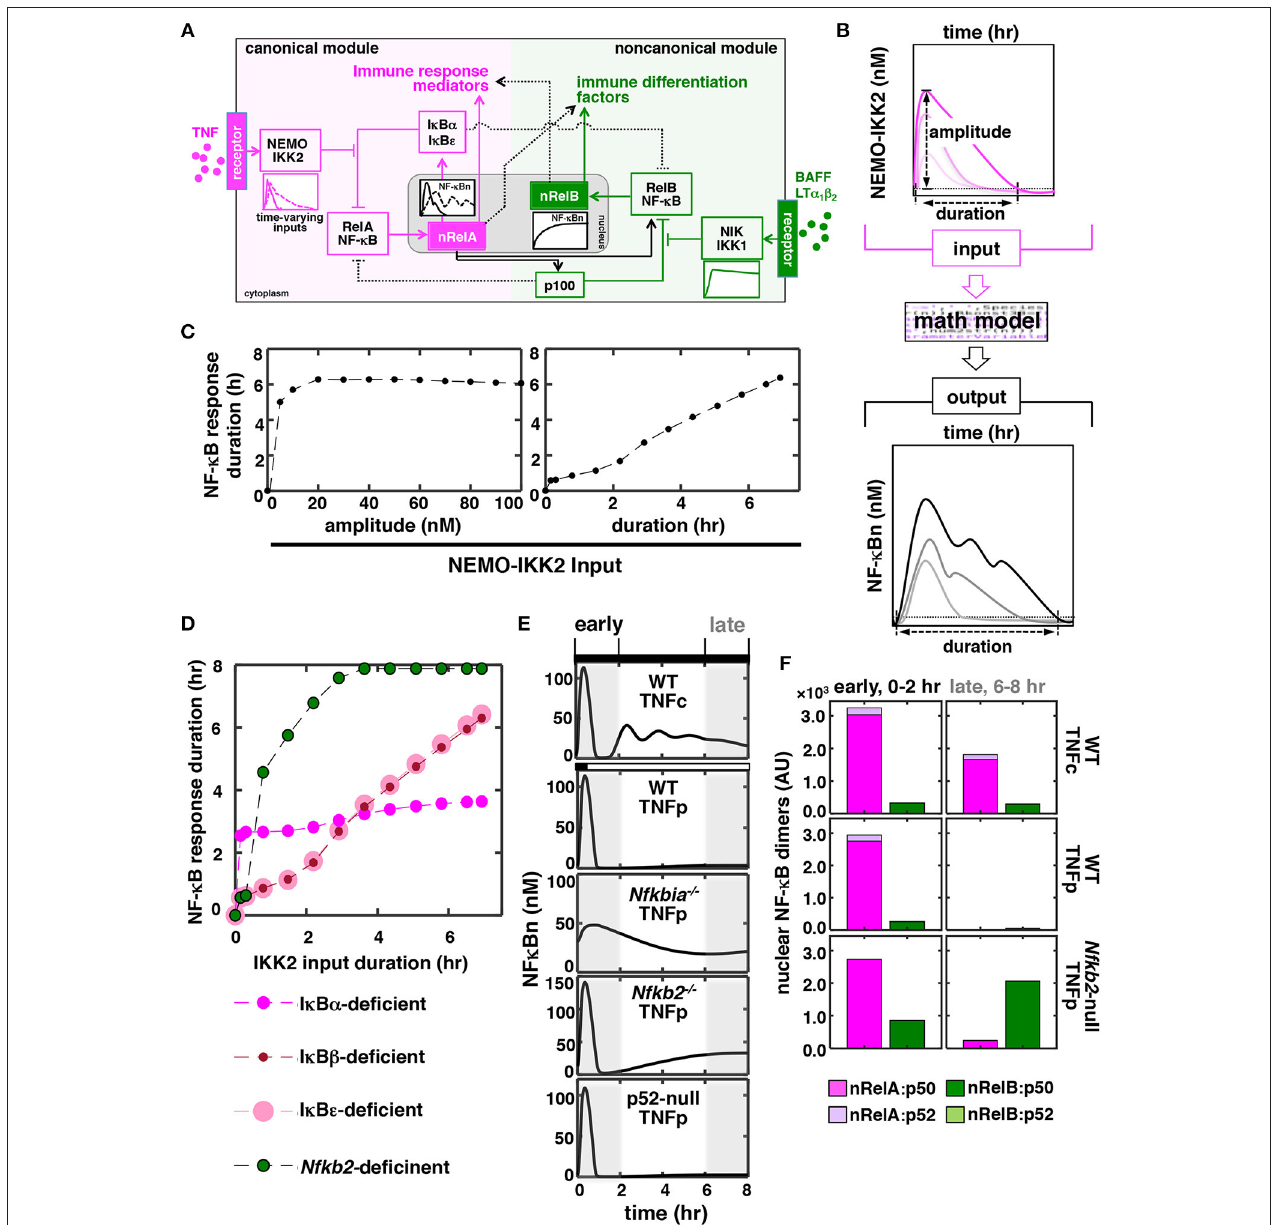
FIGURE 1 | In silico studies identify a role of p100 in discriminating between time-varying TNF inputs. (A) A graphical depiction of the NF- κ B system. TNF through the canonical pathway (magenta) dynamically regulates the activity of RelA:p50 heterodimers, which mediate the expression of immune response genes. BAFF or LT α 1 β 2 induces a distinct RelB NF- κ B activity via a separate non-canonical pathway (green) for driving the expression of immune differentiation factors. However, these two NF- κ B pathways are molecularly connected and display certain overlap in relation to gene expressions. Solid and dotted black lines represent major cross-regulatory mechanisms and those involving less-preferred biochemical reactions, respectively. NF- κ Bn, nuclear NF- κ B activity. nRelA and nRelB represent corresponding nuclear heterodimers. (B) Schema describing in silico production function analyses. Briefly, theoretical IKK2 activity profiles of various peak amplitudes and durations were fed into the mathematical model, and NF- κ Bn responses were simulated in a time-course. Durations were estimated as the time elapsed above a specific threshold value, which was determined as the sum of the basal NF- κ B or IKK activity and 5% of the corresponding basal-corrected peak activity, in the corresponding activity curves. (C,D) Graph plot of the duration of simulated NF- κ Bn responses as a function of the peak amplitude or the duration of theoretical IKK2 inputs. IKK2 activities of various peak amplitude but with invariant 8h of duration ( C , left) or with various durations but identical 60nM peak amplitude ( C , right and D ) were used. Computational simulations involved (C) the WT system and (D) the indicated mutant systems. (E) In silico studies revealing NF- κ Bn responses in a time-course in WT and various mutant systems. Experimentally derived IKK2 activity profiles, obtained using MEFs treated with TNF either chronically (TNFc) or for 0.5h (TNFp), were used as model inputs. Early (0–2h) and late (6–8h) phases have been marked using gray boxes. (F) Computational modeling predicting TNFp-induced nuclear activities of RelA and RelB heterodimers in WT and Nfkb2 -null systems. Early and late activities were determined as the area under the corresponding activity curve between 0 and 2h and 6–8h, respectively, subsequent to correction for basal values. AU, arbitrary unit.